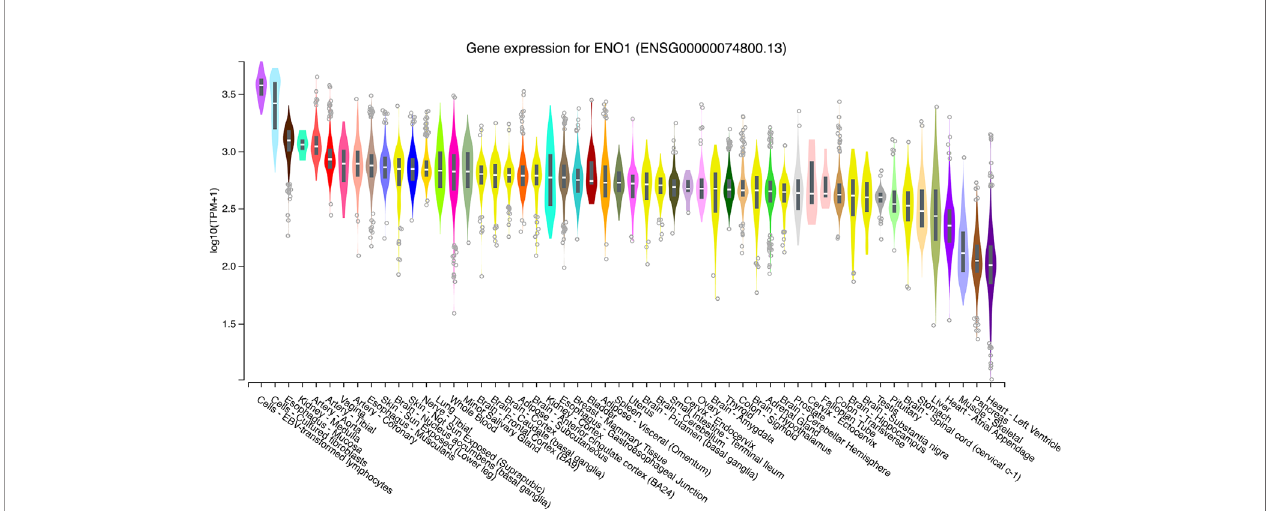
FIGURE 1 | ENO1 expression in normal tissue samples. The expression levels of ENO1 were calculated from a gene model with isoforms collapsed to a single gene and are shown in transcripts per million. The median, 25 th and 75 th percentiles are shown in the plots. Points that are above or below 1.5 times the interquartile range are shown as outliers. TPM, transcripts per million; ENO1, enolase